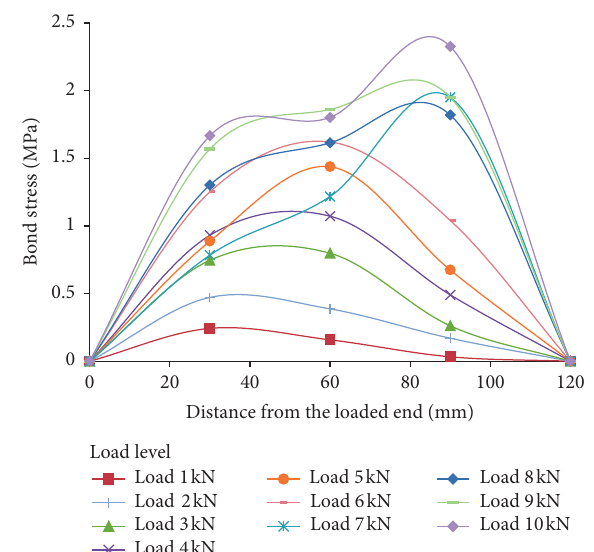
Figure 10: Bond stress distribution in the plain bar-reinforced OPC.